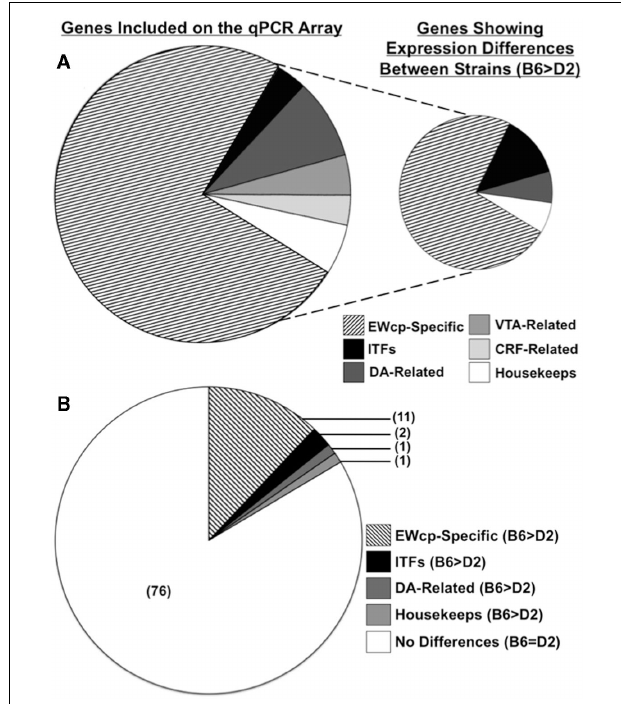
FIGURE 2 | Genes of interest included on the qPCR array, and strain differences in EWcp gene expression identified between B6 and D2 mice. (A) Pie chart on left indicates relative proportions of gene categories included on the qPCR arrays. Pie chart on right indicates relative proportions of gene categories in which strain differences were identified. (B) Pie chart showing relative proportions of gene categories in which strain differences were identified, as compared to the proportion of genes in which no differences were identified. Note that while Ucn is both CRF-related and EWcp-specific, it was included only in the EWcp-specific category for these